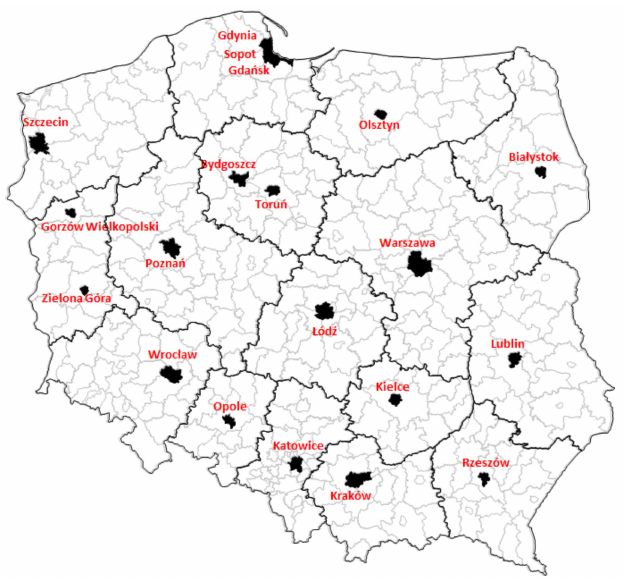
Figure 1. Poviats in Poland (research area of development potential and the natural environment). Source: own